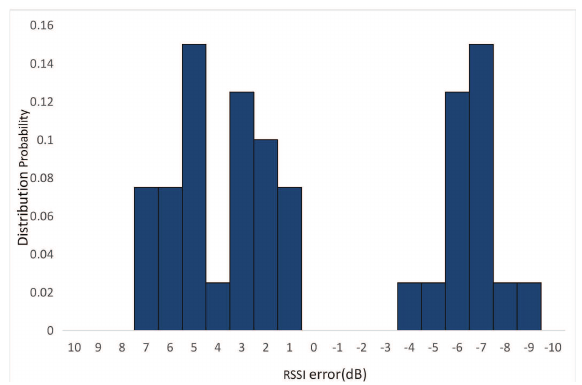
Figure 2. RSSI error